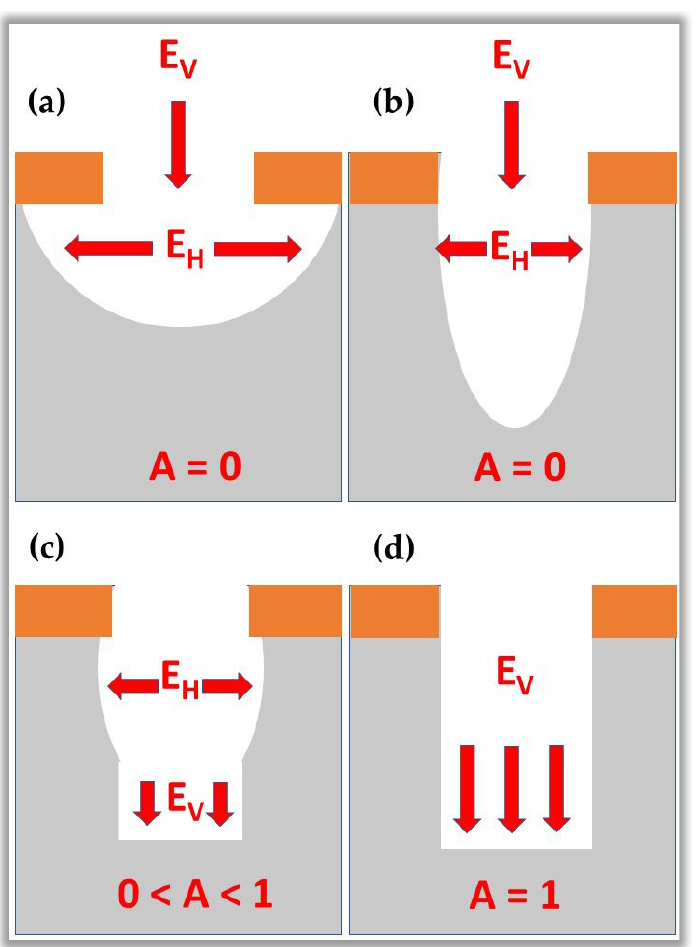
Figure 13. Etching profile types. ( a ) isotropic etching profiles ( A = 0) with lateral etching under the mask; ( b ) isotropic etching profiles ( A = 0) without etching under the mask; ( c ) partially anisotropic profile (0 < A < 1); and ( d ) perfectly anisotropic profile ( A = 1). Historically, wet etching was used in microfabrication until the late 1970s. Wet